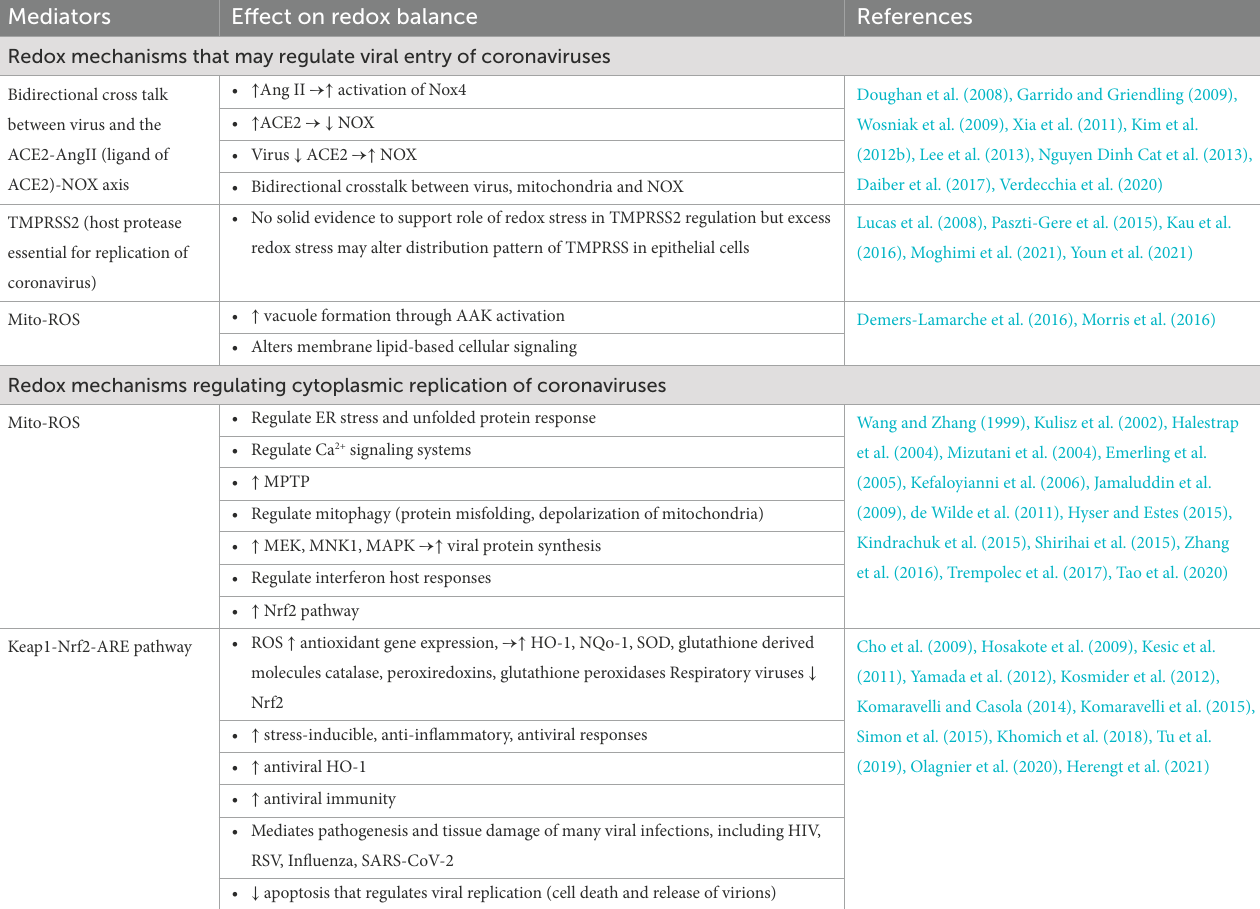
TABLE 1 Redox mechanisms that regulate replication of coronaviruses.